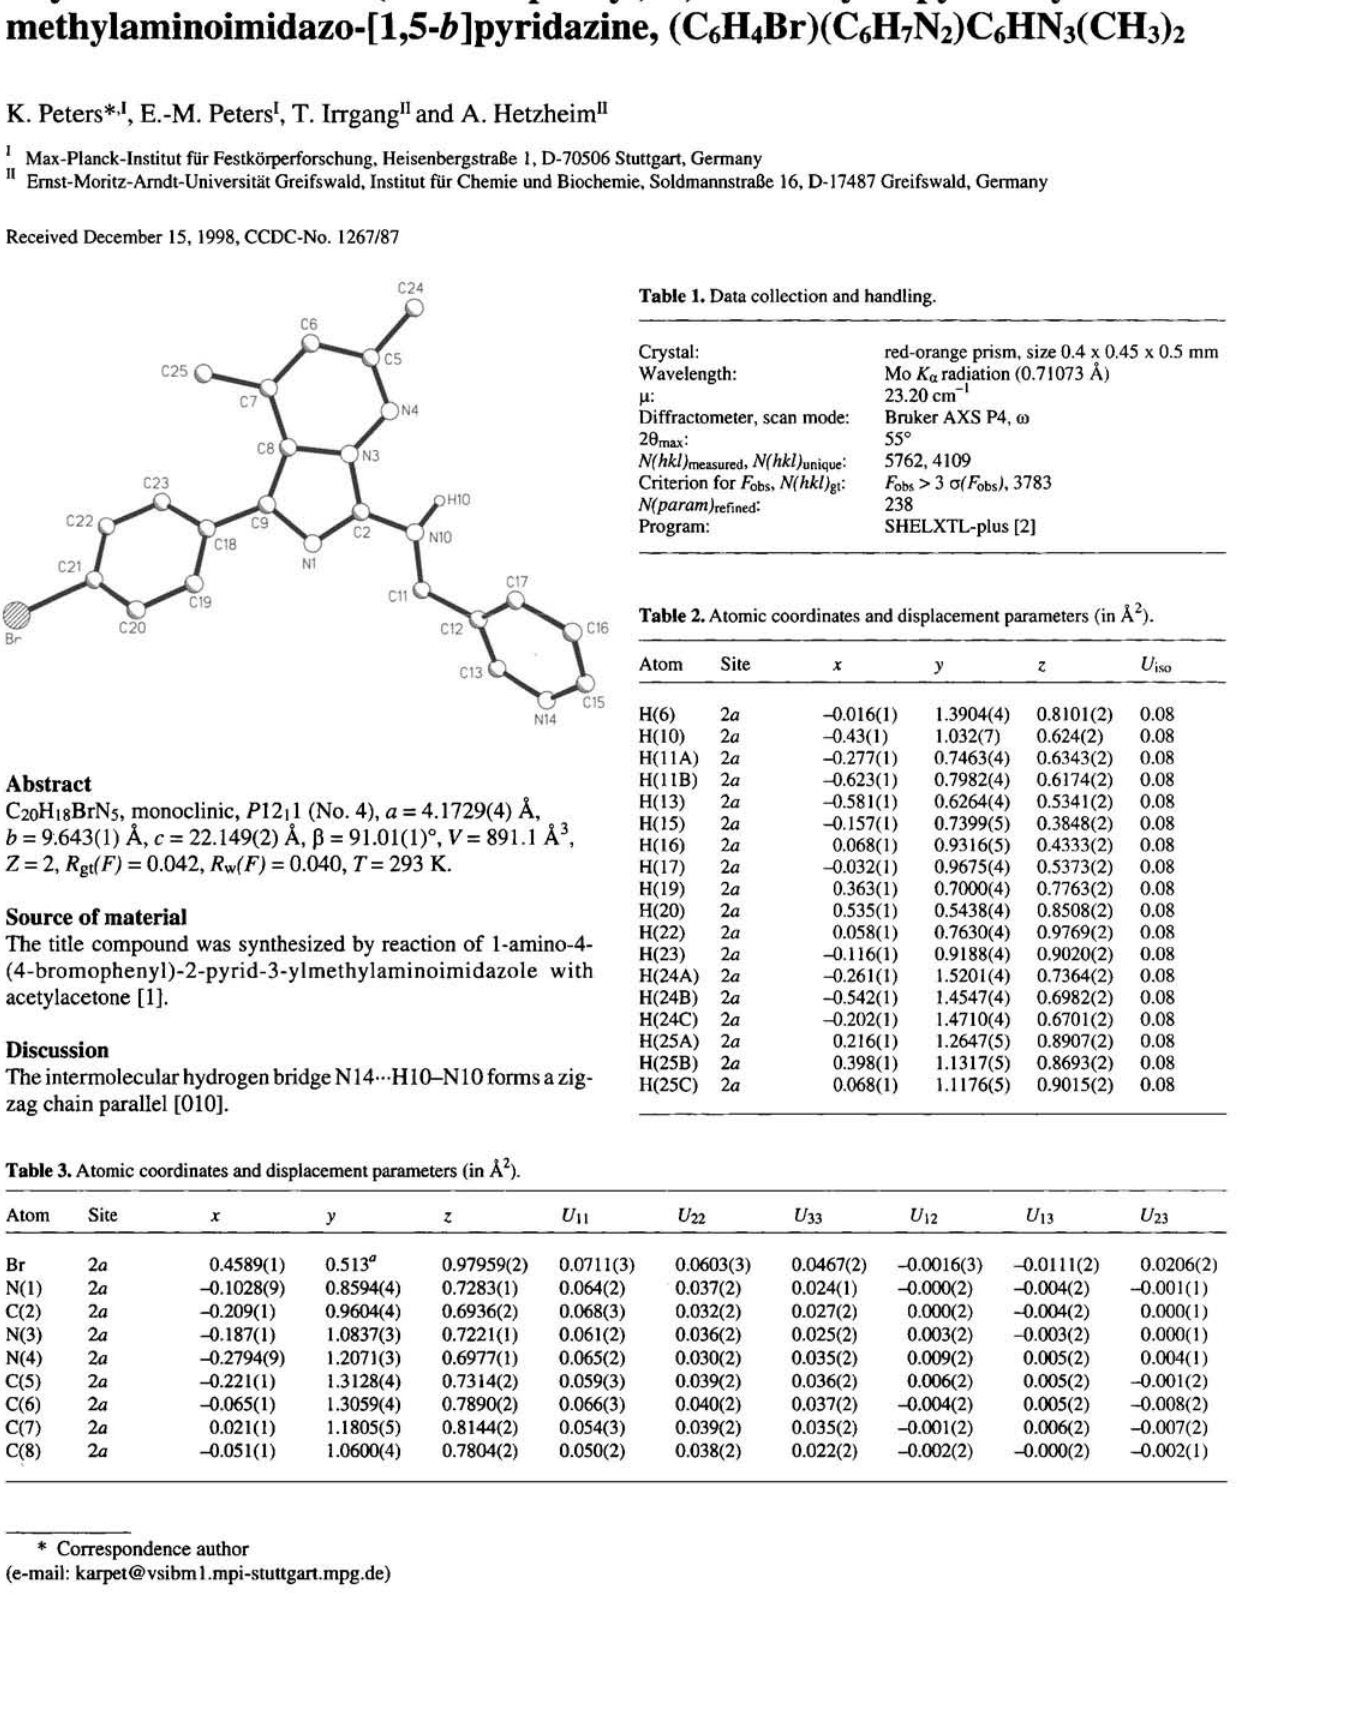
Table 3. Atomic coordinates and displacement parameters (in Â 2